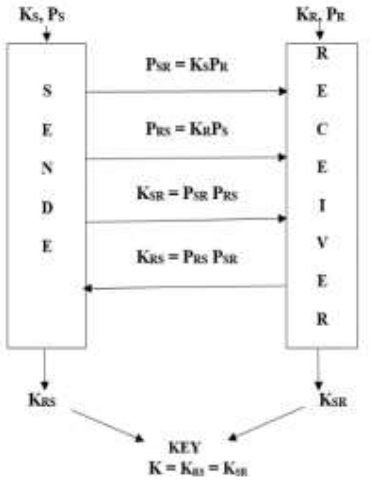
Figure 4 . Computational process for